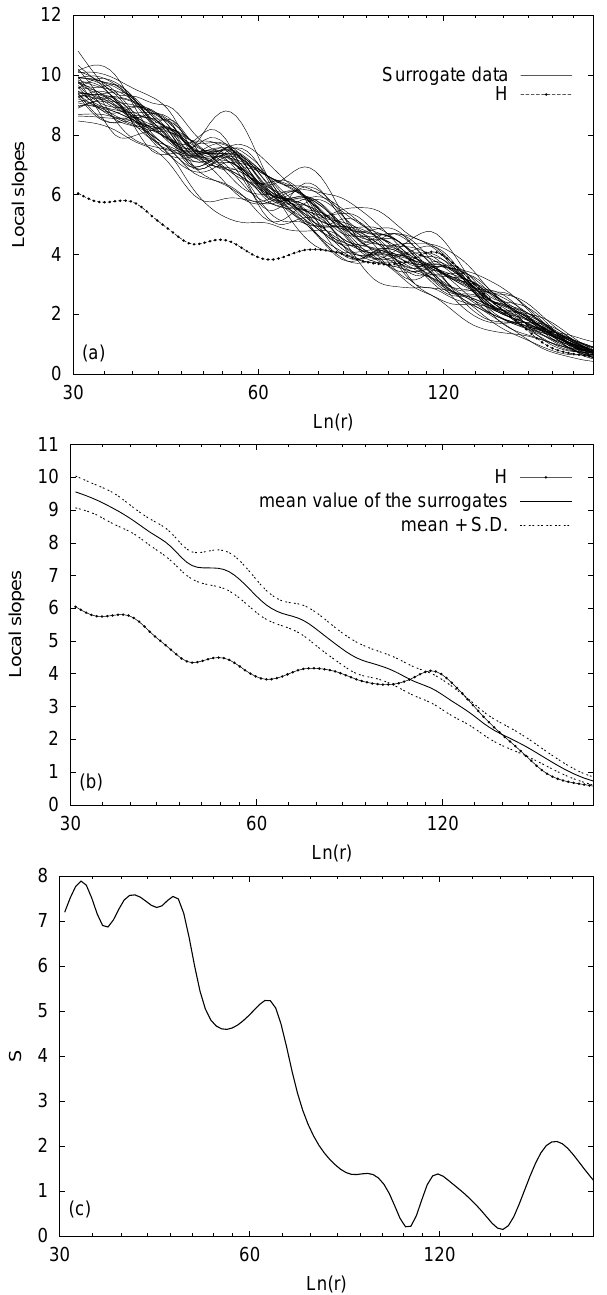
Fig. 5. (a) The local slopes of the correlation sums of the surrogates as function of ln (r) for m = 12 , τ = 10 and ω = 100 . (b) The mean values of the local slopes of the surrogates with standard deviation for m = 12 , τ = 10 and ω = 100 . (c) Plot of the significance of the difference S versus ln (r).